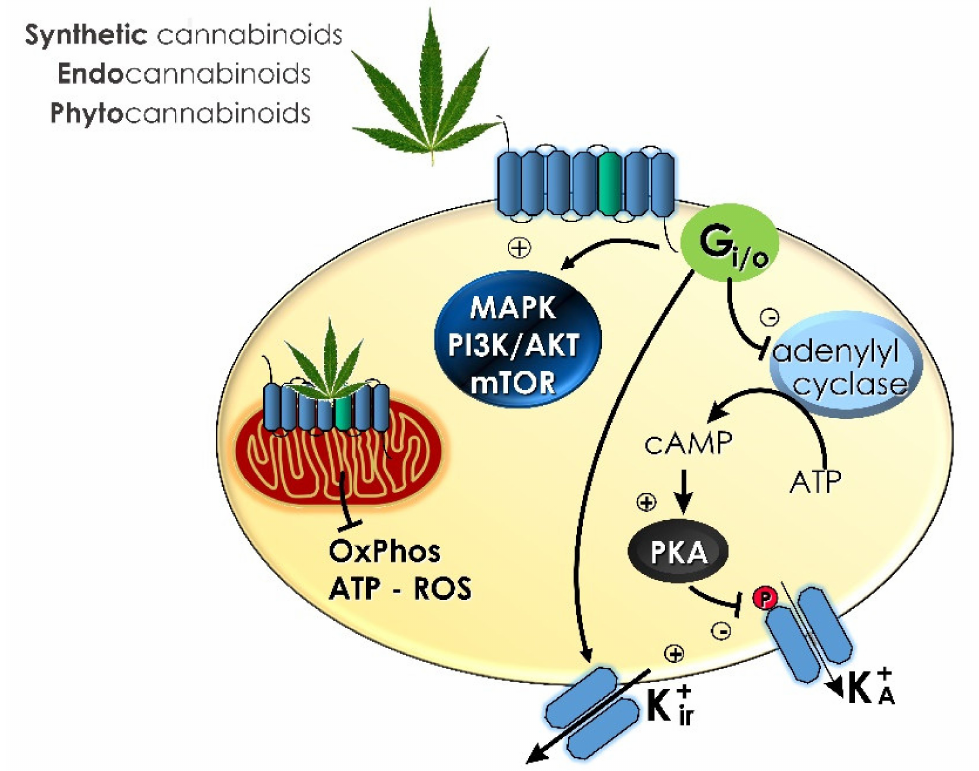
Figure 2. Summary of the signaling pathways associated with cannabinoid